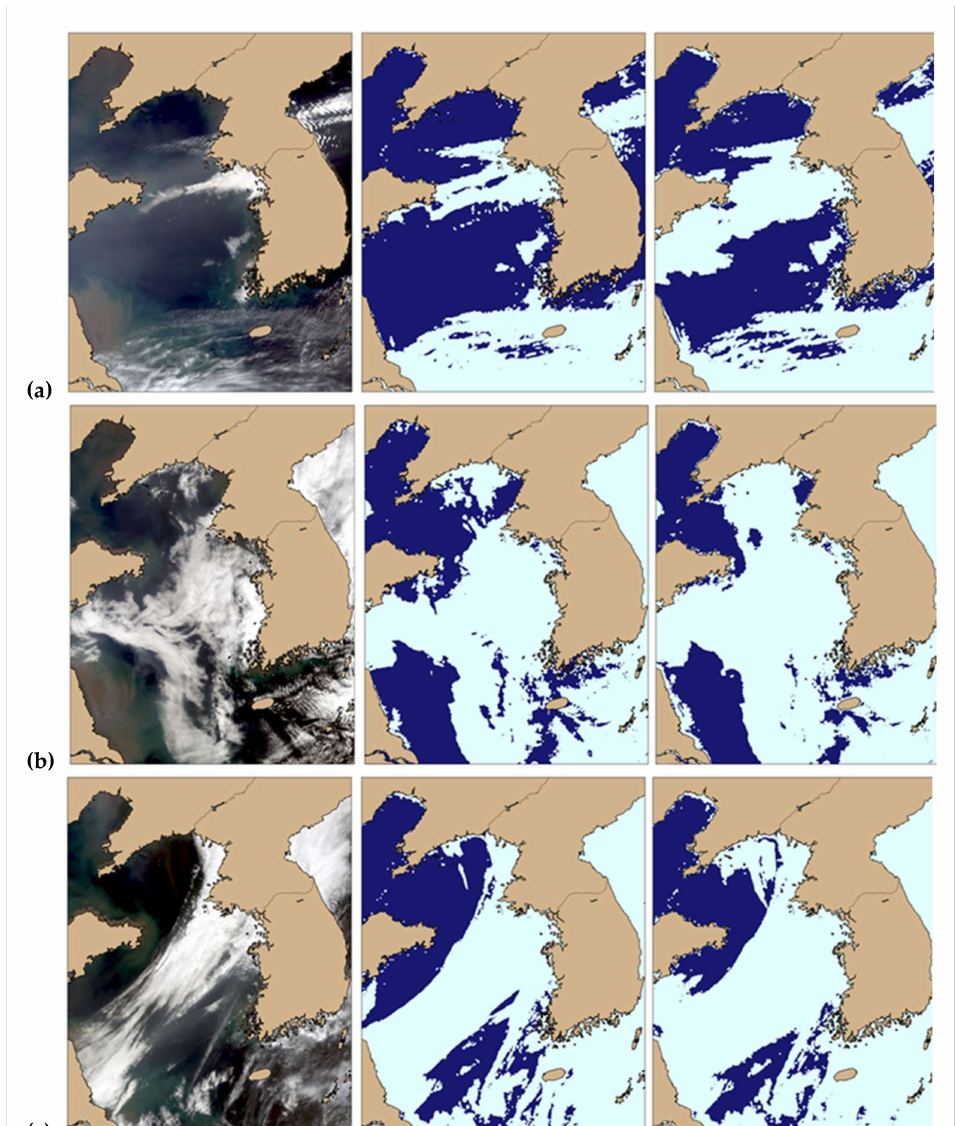
Figure 13. RGB images of a mixture of clouds and dust (left column), the proposed CM (middle column), and MODIS CM (right column) on ( a ) 2 April 2001, 02:25 UTC; ( b ) 8 April 2003, 02:15 UTC; and ( c ) 16 April 2015, 02:20